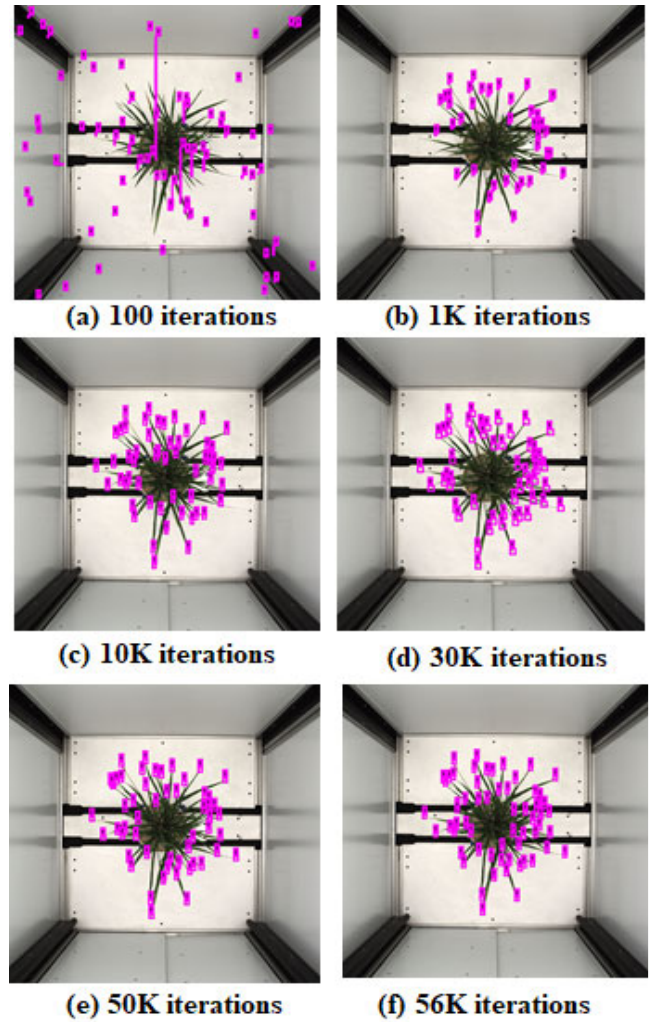
Figure 8. Training the model at different iterations of ( a ) 100, ( b ) 1K, ( c ) 10K, ( d ) 30K, ( e ) 50 K and ( f ) 56K iteration, and each iteration’s result for detection and prediction of leaf tip, a tiny object . We started our model training with the initial learning rate set to 0.001 with a decay of 0.0005 applied at iterations of 40 K and 45 K, and the batch size of the images, of 16. We